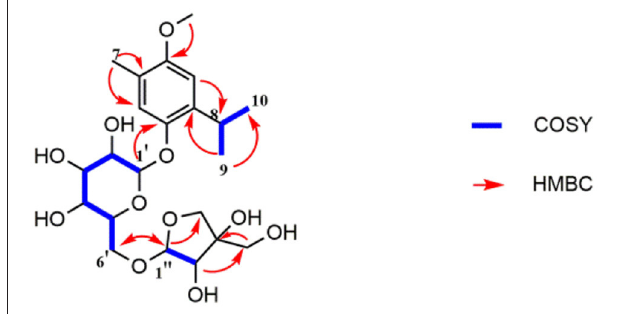
FIGURE 2 | Key 1 H- 1 H COSY and HMBC correlations of compound 1